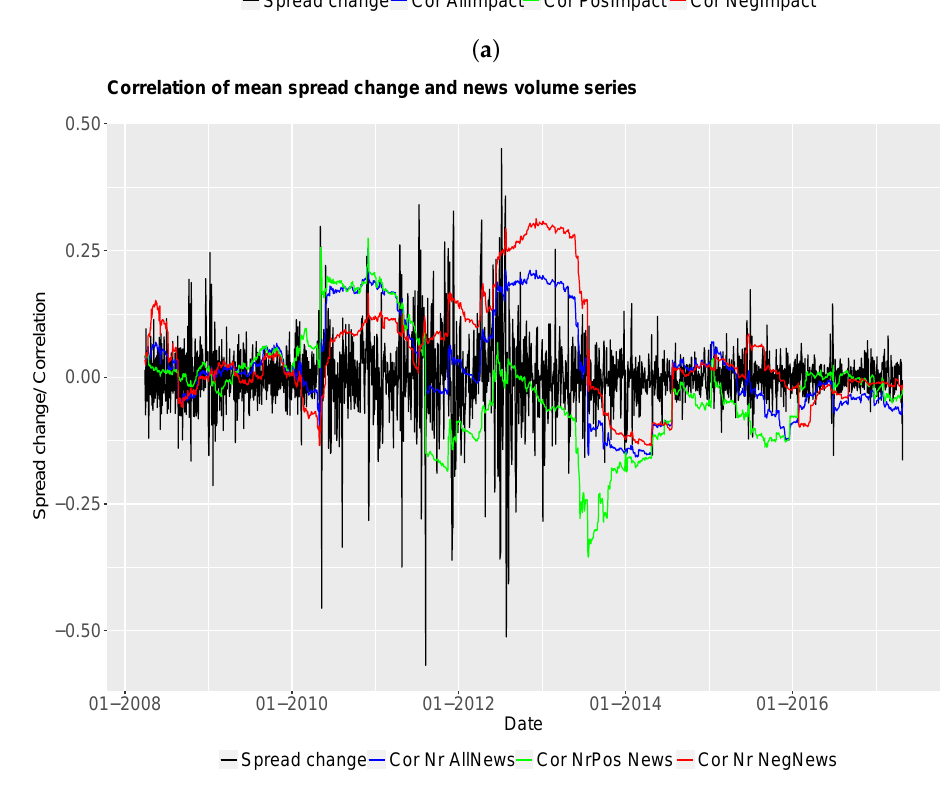
Figure 7. Rolling correlations between mean spread change in Spain and ( a ) the impact of news and ( b ) the volume of